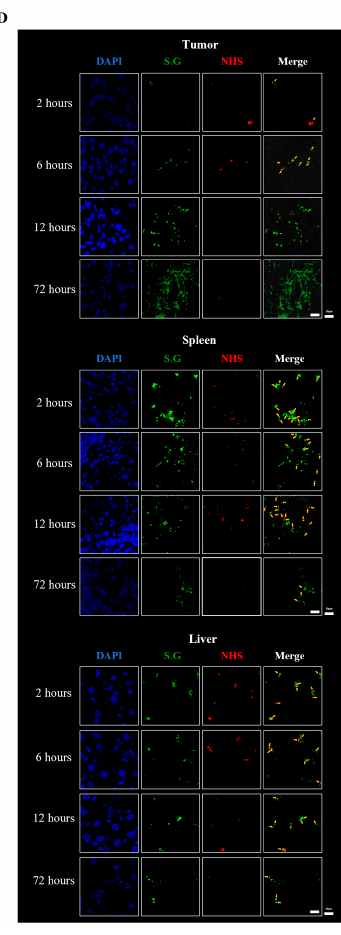
Figure 2. Fate of ∆ ppGpp S. Gallinarum injected into tumor-bearing mice. ( A ) Images of ∆ ppGpp S. Gallinarum cross-linked with a red fluorescent dye (Flamma ® Fluors 552 NHS ester) grown in LB medium for the indicated amounts of time. Bacteria stained with a fluorescent antibody are shown in green and DAPI-stained nuclei are shown in blue. Scale bar = 5 µ m for 1000 × magnification. ( B ) The red fluorescent bacteria were grown in LB with vigorous aeration. At the indicated time points, samples were collected to measure cell mass (A 600 ) and red fluorescent signals using a fluorometer at an excitation wavelength of 550 nm and an emission wavelength of 610 nm. A.U. = red fluorescent signal/A 600 . ( C ) ∆ ppGpp S. Gallinarum was intravenously injected into CT26 tumor-bearing mice ( n = 4/group, 1 × 10 8 CFU/mouse) when tumor size reached 130–150 mm 3 . Bacterial loads from isolated tumors, livers, and spleens were determined at the indicated times after the injection (related to data shown in Figure S3). ( D ) The fluorescent bacteria were intravenously injected into mice grafted with CT26 cancer cells ( n = 5, 1 × 10 8 CFU/mouse). The Salmonella in tumors, spleens, and livers at the indicated time points were observed under a confocal microscope. Bacteria cross-linked with Flamma ® Fluors 552 NHS ester are shown in red, bacteria stained with a fluorescent antibody are shown in green, and DAPI-stained nuclei are shown in blue. Yellow arrows indicate merged red and green bacterial signals. Scale bar = 10 µ m for 800 × magnification. ( E ) The fractions of red fluorescent bacteria (indicated by arrows) among green bacteria (total number) in each organ and tumor tissue at 12 h postinjection are shown in a graph (fraction of red fluorescent bacteria = red/green × 100, %). Results are expressed as the mean ± SD from five sections, unpaired Student’s t -tests, p < 0.0001. ( F ) ∆ ppGpp S. Gallinarum carrying prrnBp1-gfpOVA (SMP4001) was administered to CT26-grafted mice ( n = 5/group) via the tail vein, and gfpOVA expression from the rrnB P1 promoter in the bacteria in tumors, livers, and spleens at the indicated time points was determined by quantitative real-time PCR. The gfpOVA Ct values were calculated relative to S. Gallinarum rpoB Ct values in triplicate. All data are expressed as the mean ± SD. Significant differences are shown as p < 0.05 (unpaired Student’s t -tests; ns: not